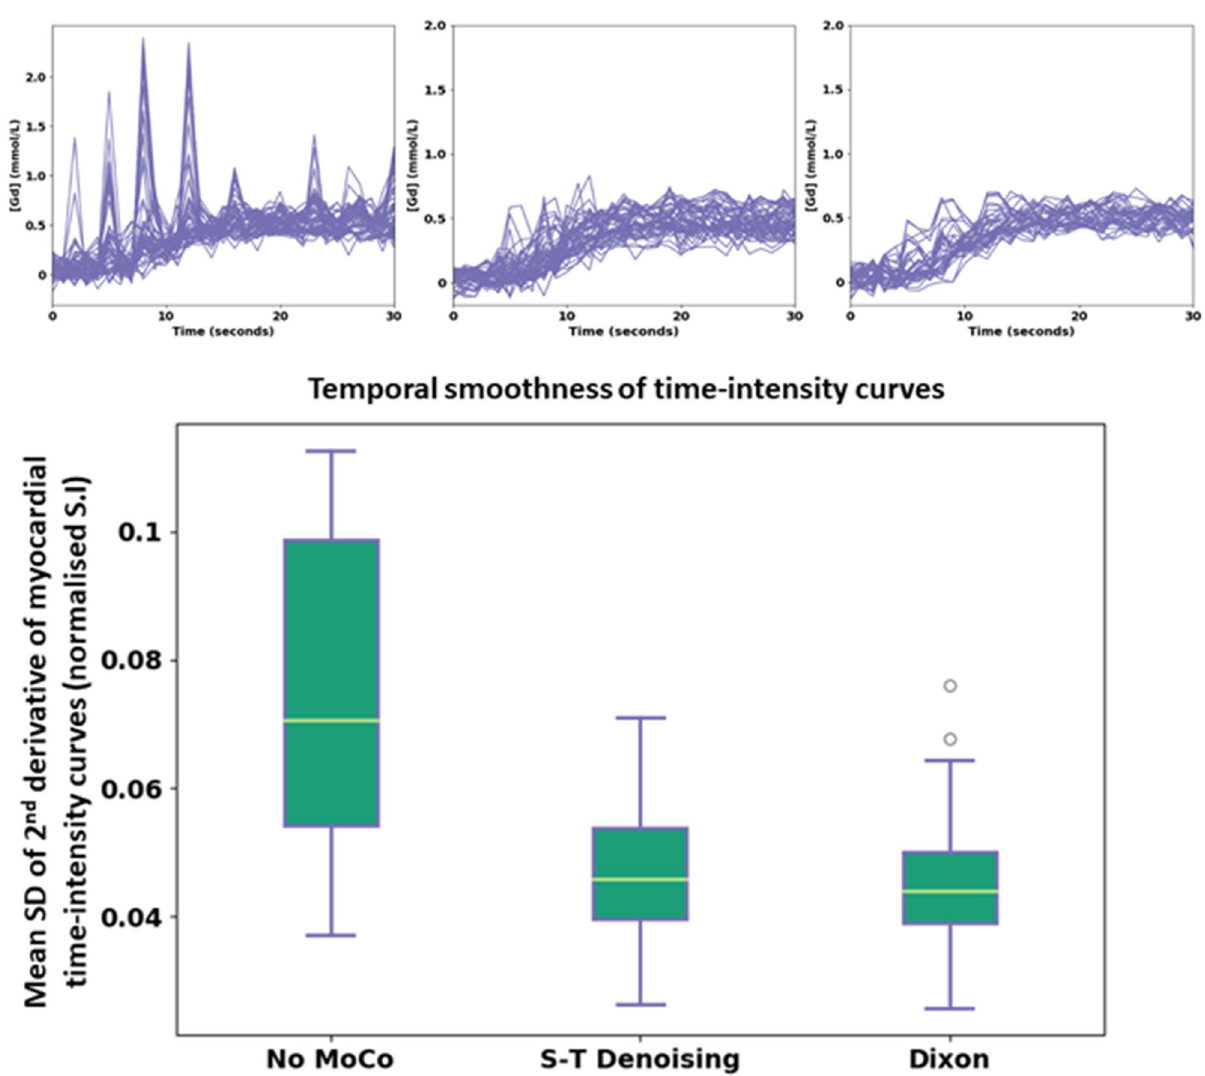
Figure 4. The boxplots distributions of the temporal smoothness metric for the no MoCo, S-T denoising and Dixon MoCo images respectively. As expected, the S-T denoising and Dixon MoCo images are significantly smoother than the images without motion correction. The Dixon MoCo images are seen to be marginally smoother than the S-T denoising images. The top row shows the time-intensity curves from an example image series, in the same